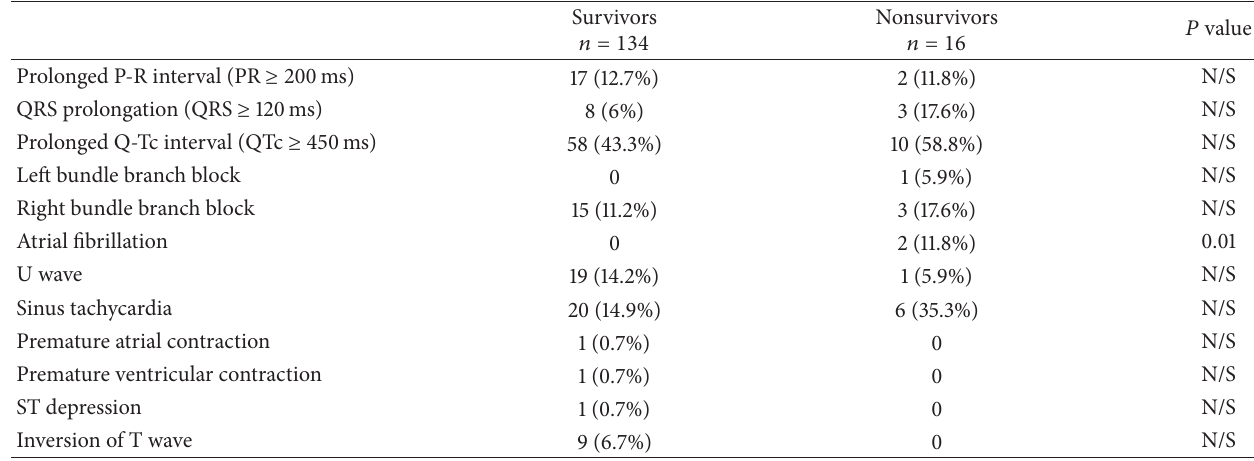
Table 3: ECG findings in studied cases ( 𝑛 = 151 ).